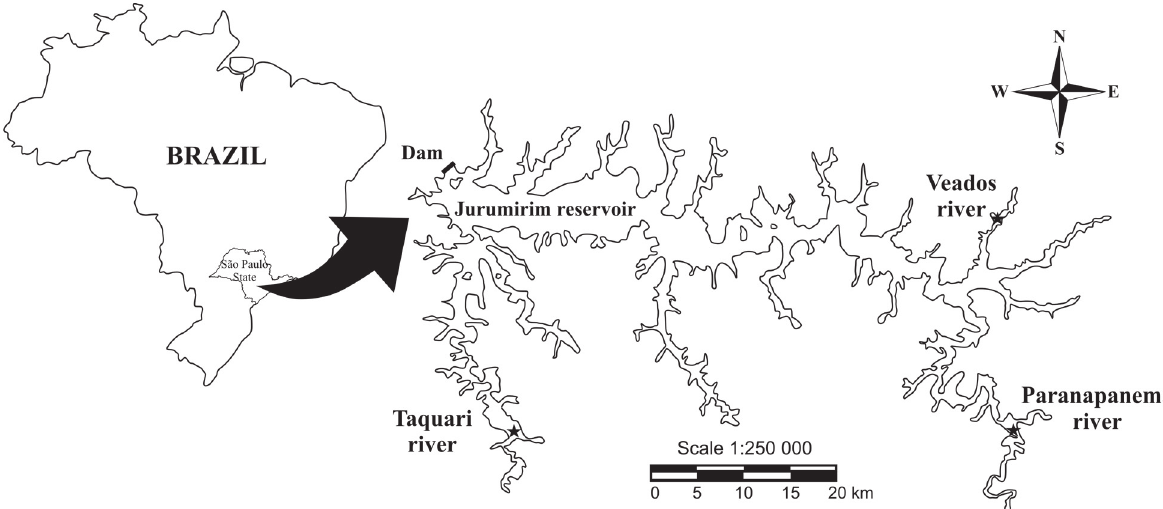
Figure 1 - The Jurumirim reservoir with the marked sampling site (stars), Upper Paranapanema River, São Paulo State, Brazil.